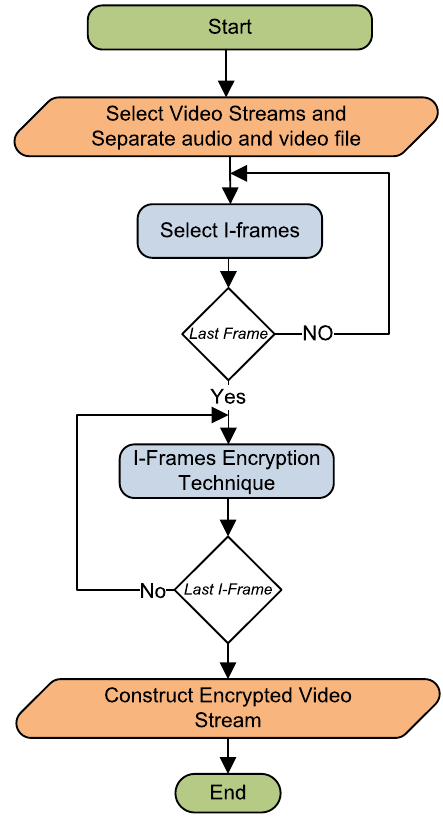
Fig. 2 Flowchart of video encryption technique